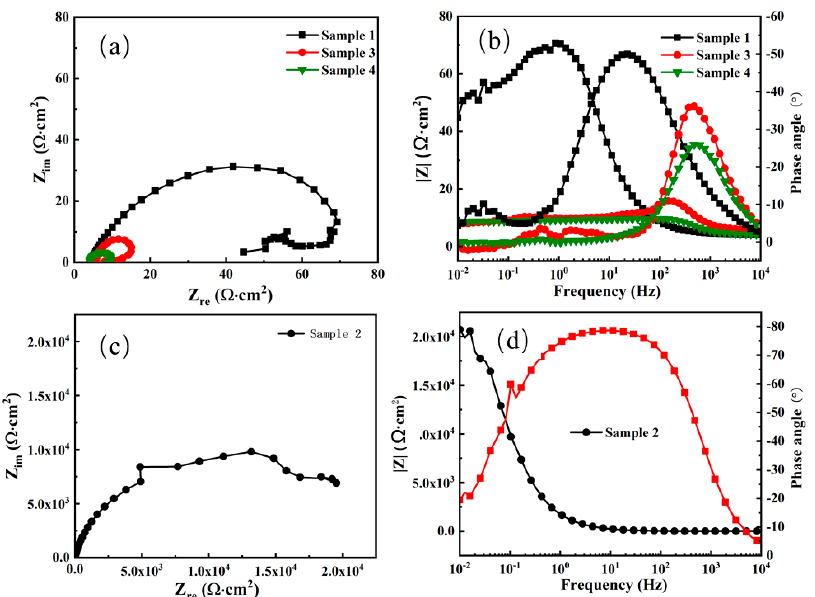
Figure 8. Nyquist and Bode plots of samples. ( a , b ) corresponds to the Nyquist and Bode plots of sample 1, 3, and 4, re- spectively, ( c , d ) the Nyquist and Bode plots of sample 2, respectively. Equivalent electrical circuits were employed to analyze the EIS data of the